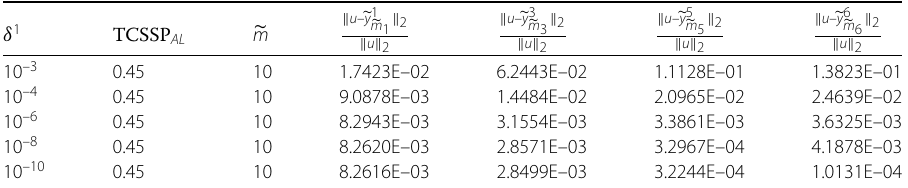
Table 1 TCSSP AL , iteration numbers, relative L 2 norm of the errors obtained by Algorithm A for Example